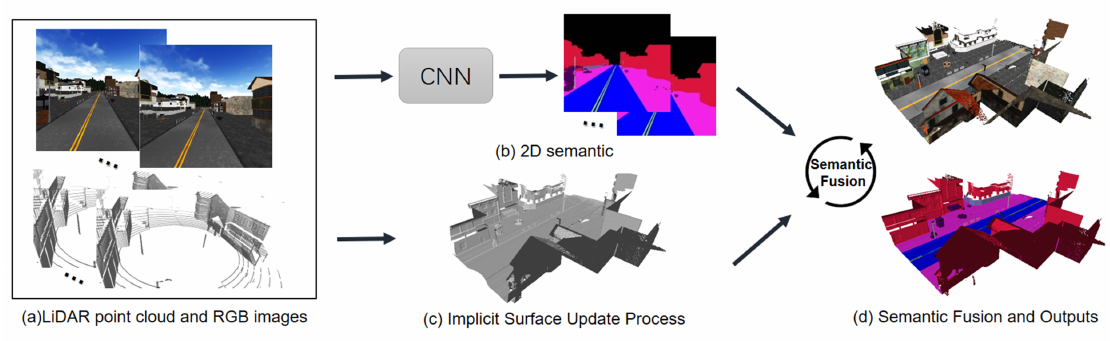
Figure 1. Overview of our pipeline. ( a ) multi-frame Lighting Detection and Ranging (LiDAR) point clouds and RGB images as input; ( b ) two-dimensional (2D) semantic segmentation network; ( c ) the implicit surface update process; and, ( d ) semantic fusion module and 3D semantic mapping